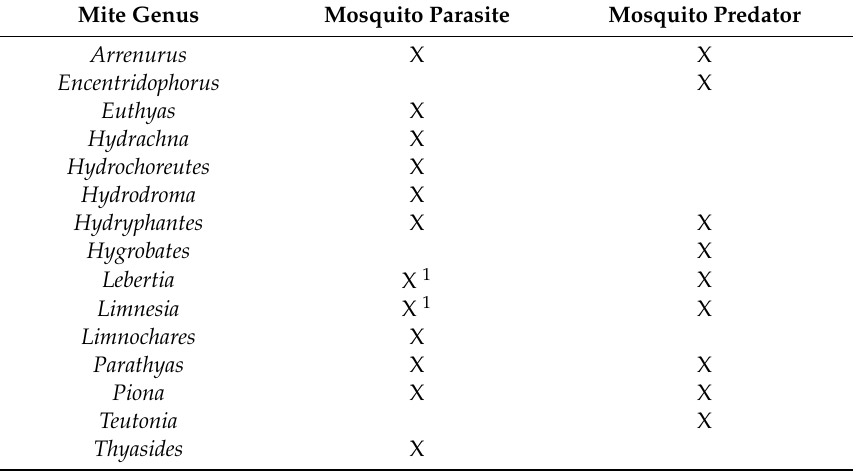
Table 4. Overlap of water mite parasites and predators of mosquito adult and larvae, respectively.